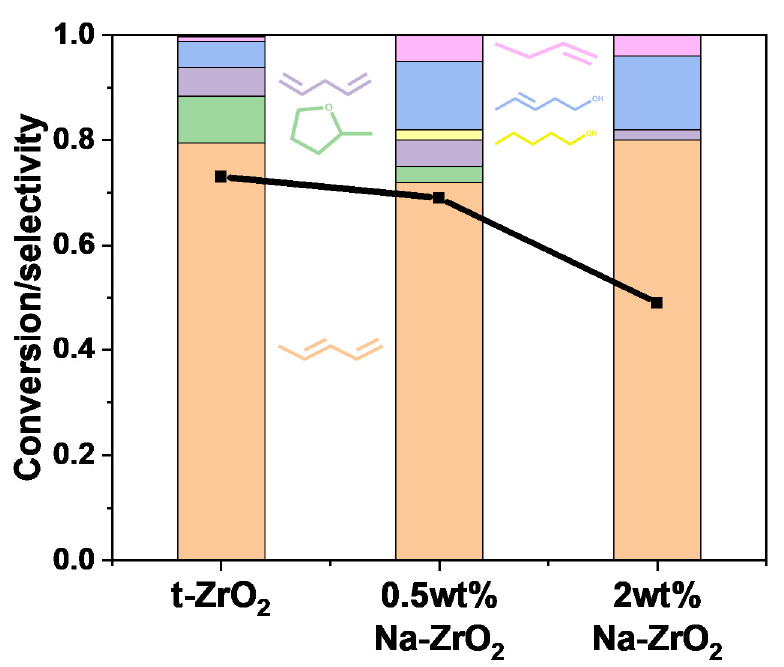
Figure 2. Product distribution for reaction of 4P1OL on ZrO 2 at 673 K as a function of the Na loading (WHSV = 2.22 g 4P1OL/g cat/h). Conversion: ◼ ; color code for product selectivity bars: orange-1,3-pentadiene, green-2-MTHF, purple-1,4-pentadiene, yellow-pentanol, blue-3-penten-1-ol, pink-butene(s).